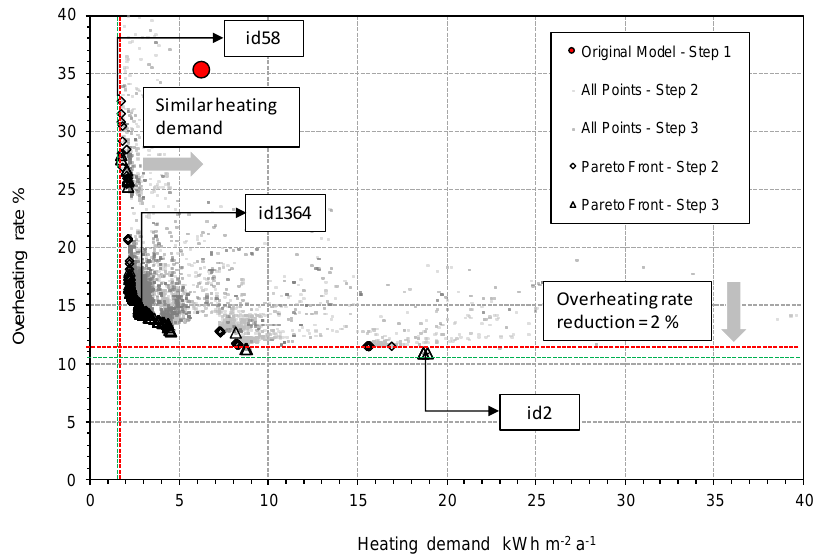
Figure 8. Pareto fronts and all simulated results: Step 3.